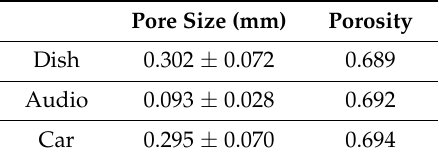
Table 1. Properties of sponge